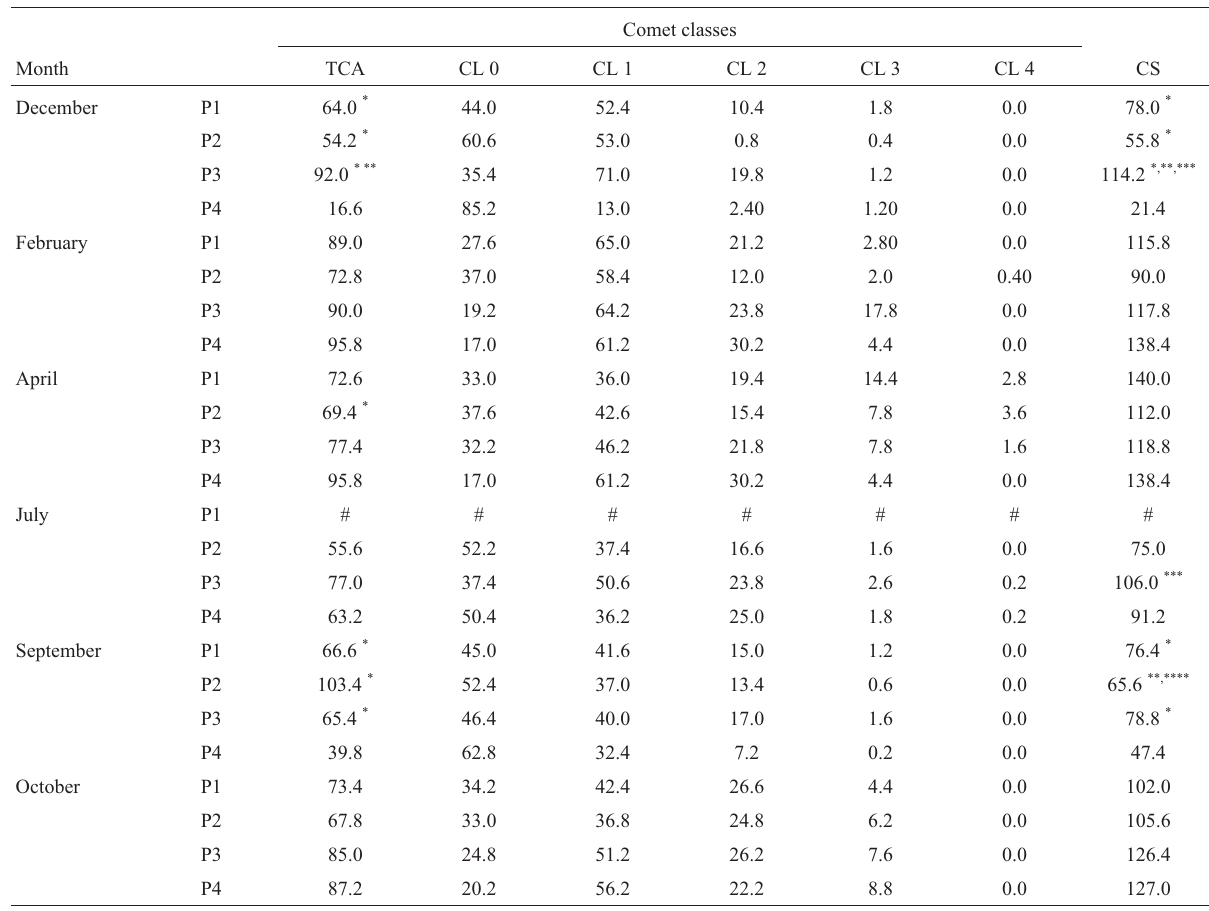
Table 7 - Average total cells with comet alterations (TCA), different comet classes (CL), and cell scores (CS) observed in Astyanax altiparanae erythro- cytes exposed to P1, P2, and P3 water samples collected from the Água Boa stream (Dourados, MS), in addition to groundwater (P4), during the study